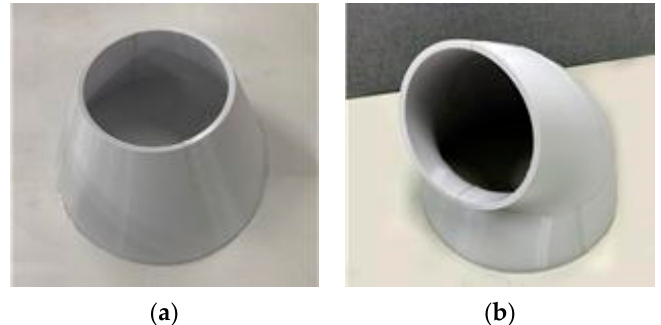
Figure 4. Discharge outlet made with a 3D print.: ( a ) Discharged upward ( b ) Discharged toward occupants.